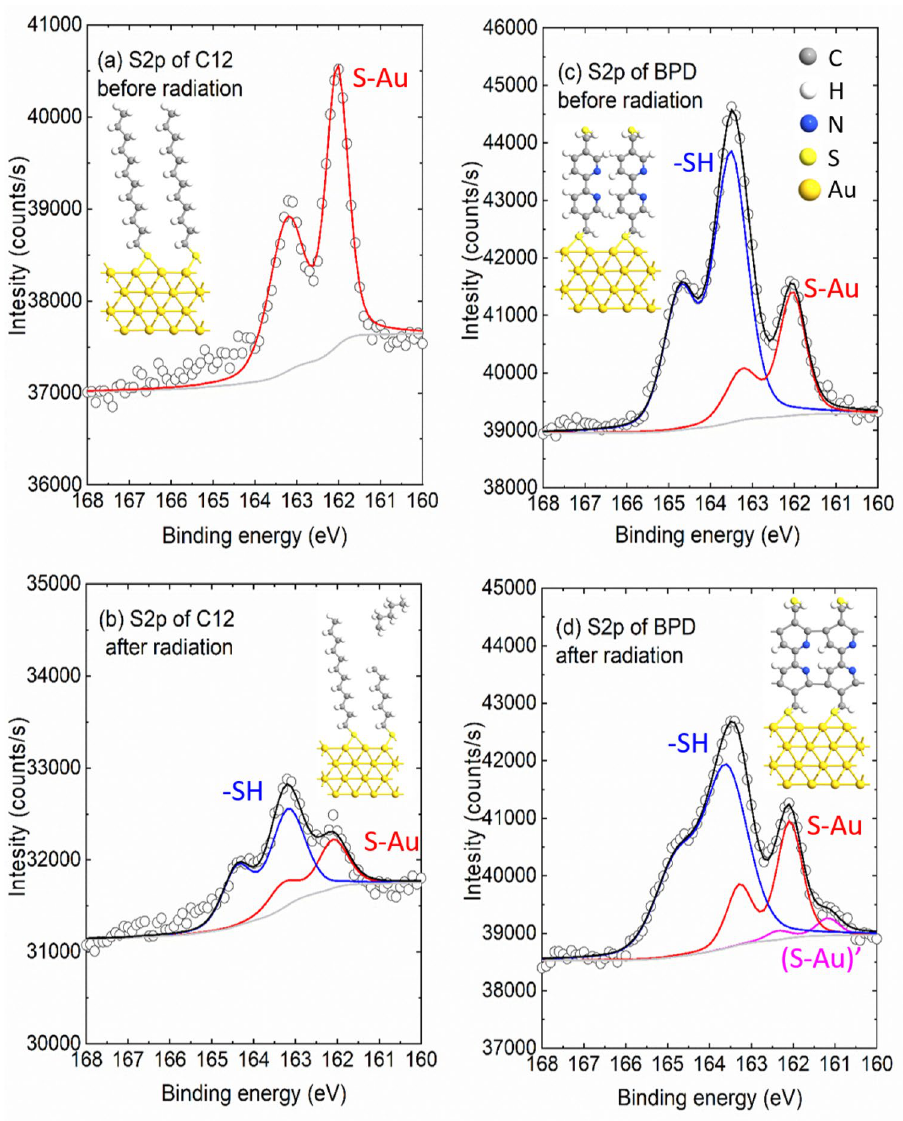
Figure 1. The S2p core level spectra of C12 ( a, b ) and BPD ( c , d ) SAMs before ( a , c ) and after ( b , d ) the electron beam irradiation. The intensities are normalized to the corresponding Au4f signal. Spectra are fitted with a Voigt profile after a Shirley background subtraction. The three components are utilized here: the free S–H at around 163.5 eV (blue), the S–Au bonding at around 162.0 eV (red) and another (S–Au)’ bonding position at around 161.0 eV (purple). Insets in ( a ) and ( c ) show optimized structures of C12 ( a ) and BPD ( c ) molecules on gold surface. Insets in ( b ) and ( d ) illustrates possible structural changes of C12 ( b ) and BPD ( d ) SAMs after electron